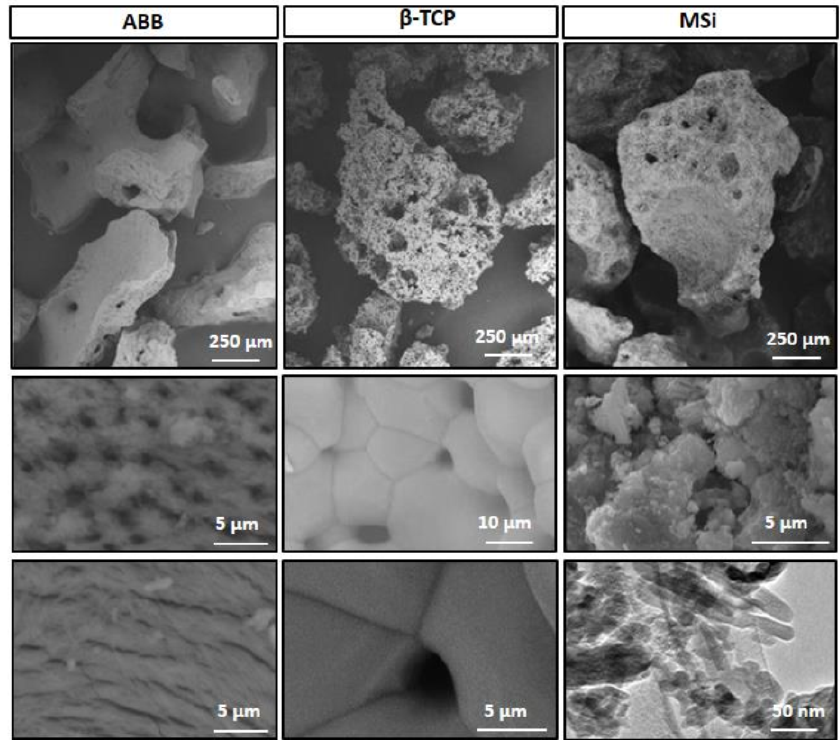
Figure 3. SEM micrograph of the studied materials. Granules had irregular shapes with sharper edges in ABB and smooth edges in β -TCP and MSi. ABB particles showed a porous surface with two pore morphologies. β -TCP showed the typical morphology of sintered materials with pores between grain boundaries. MSi showed a rough surface formed by agglomerates of similar porous morphology. These agglomerates are formed by homogeneously distributed nanometric particles, as observed in TEM images at the bottom right of the